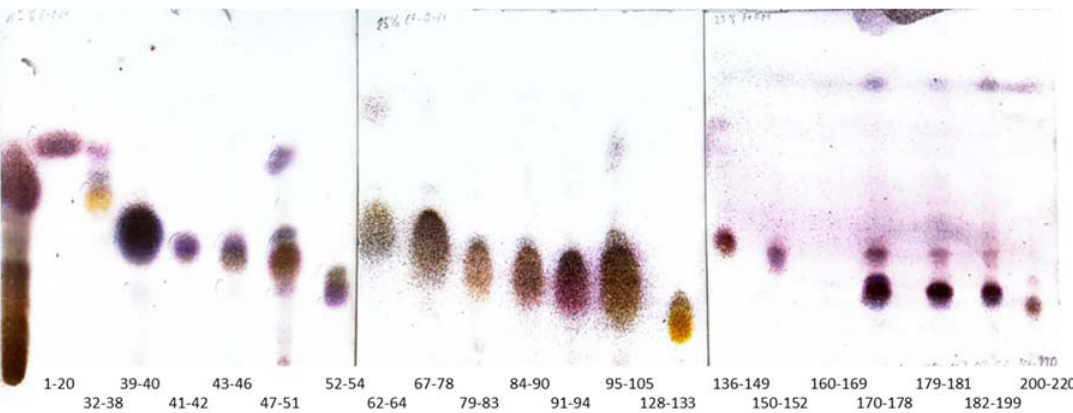
Figure 1. TLC chromatograms (NP Silica Gel TLC plates, Merck, Darmstadt, Germany) obtained for the collective fractions from column 1 in the following solvent systems: 15% of diethyl ether in n -hexane (fractions 1–54), 25% of diethyl ether in n -hexane (fractions 62–133) and 29% of diethyl ether in n -hexane (fractions 136–220) detected by a solution of p-anisaldehyde in methanol. Table 1. The GC-MS identification data on volatile components present in three collective fractions from column 1 and their content in three studied total